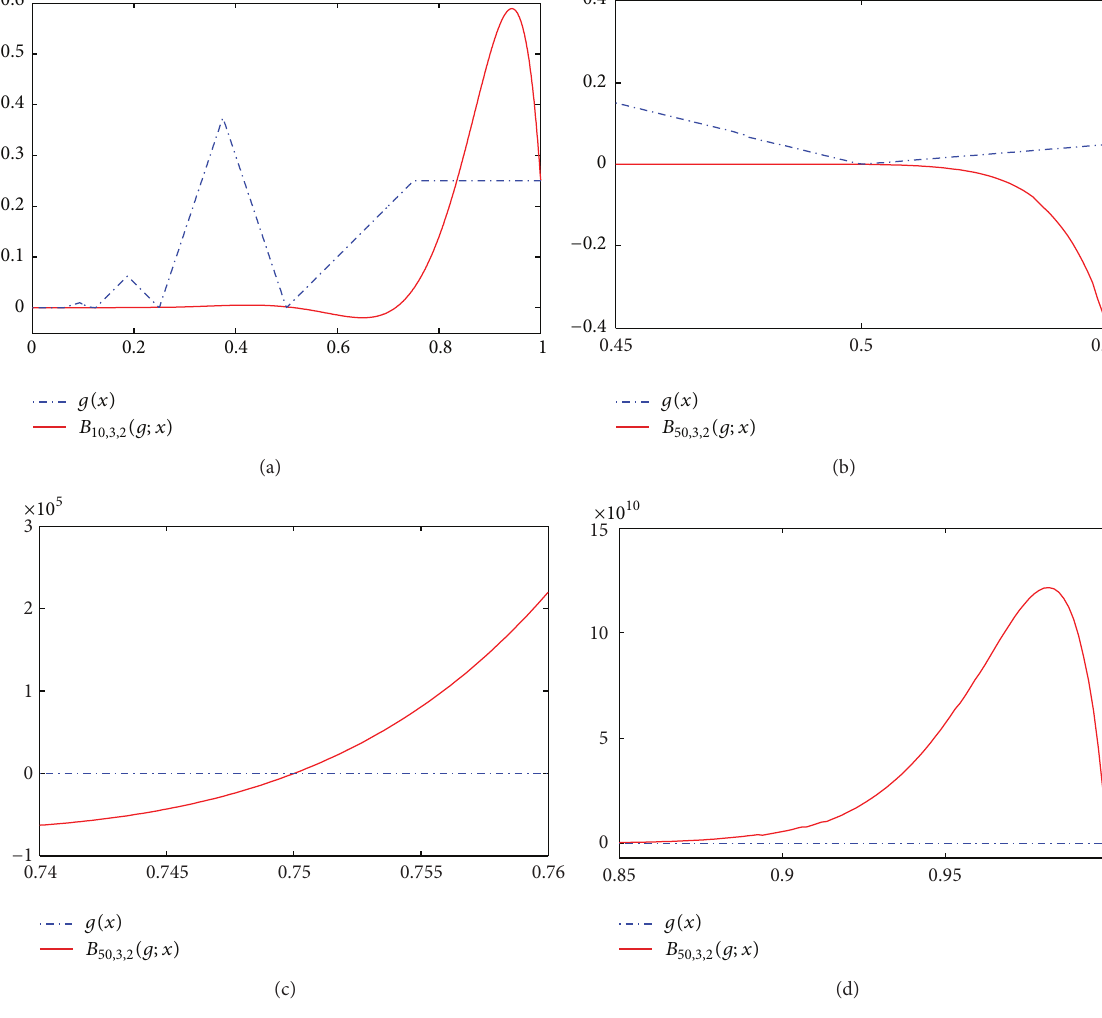
Figure 2: Graphs of 𝑔 and 𝐵 𝑛,3,2 (𝑔) on different intervals for some values of 𝑛